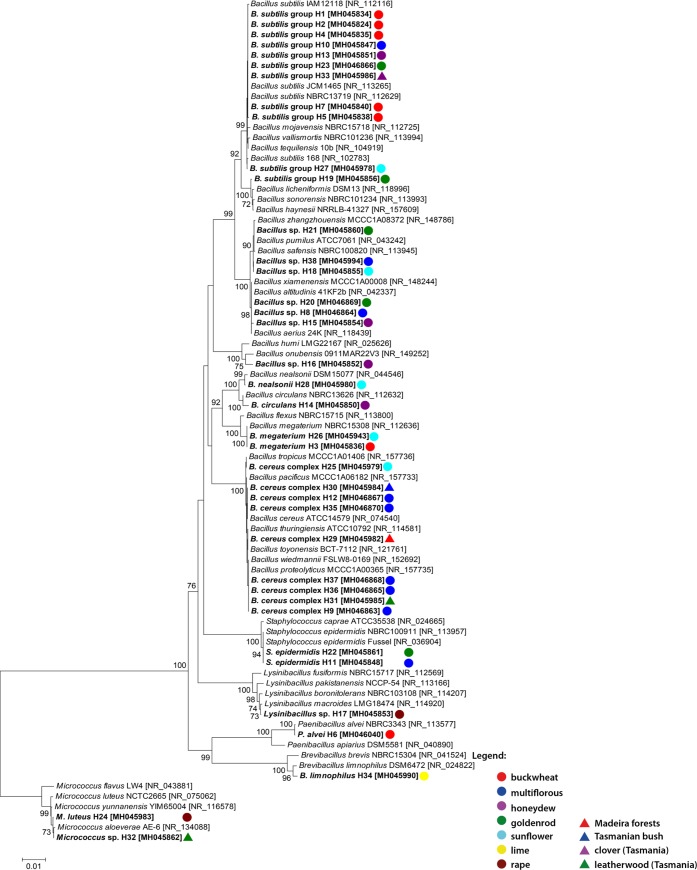
The phylogenetic tree of identified bacterial species based on the 16S rDNA analysis.The phylogenetic analysis performed including the bootstrap value. Botanical origin was marked with different colors.